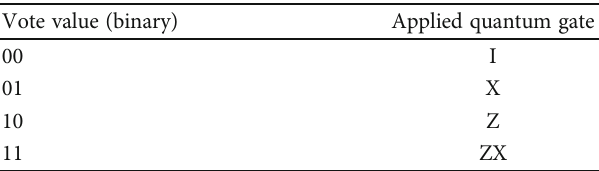
Table 1: Applied gate in correspondence with the vote value, used in the superdense coding circuit, where one qubit belongs to the voter and the other one to the